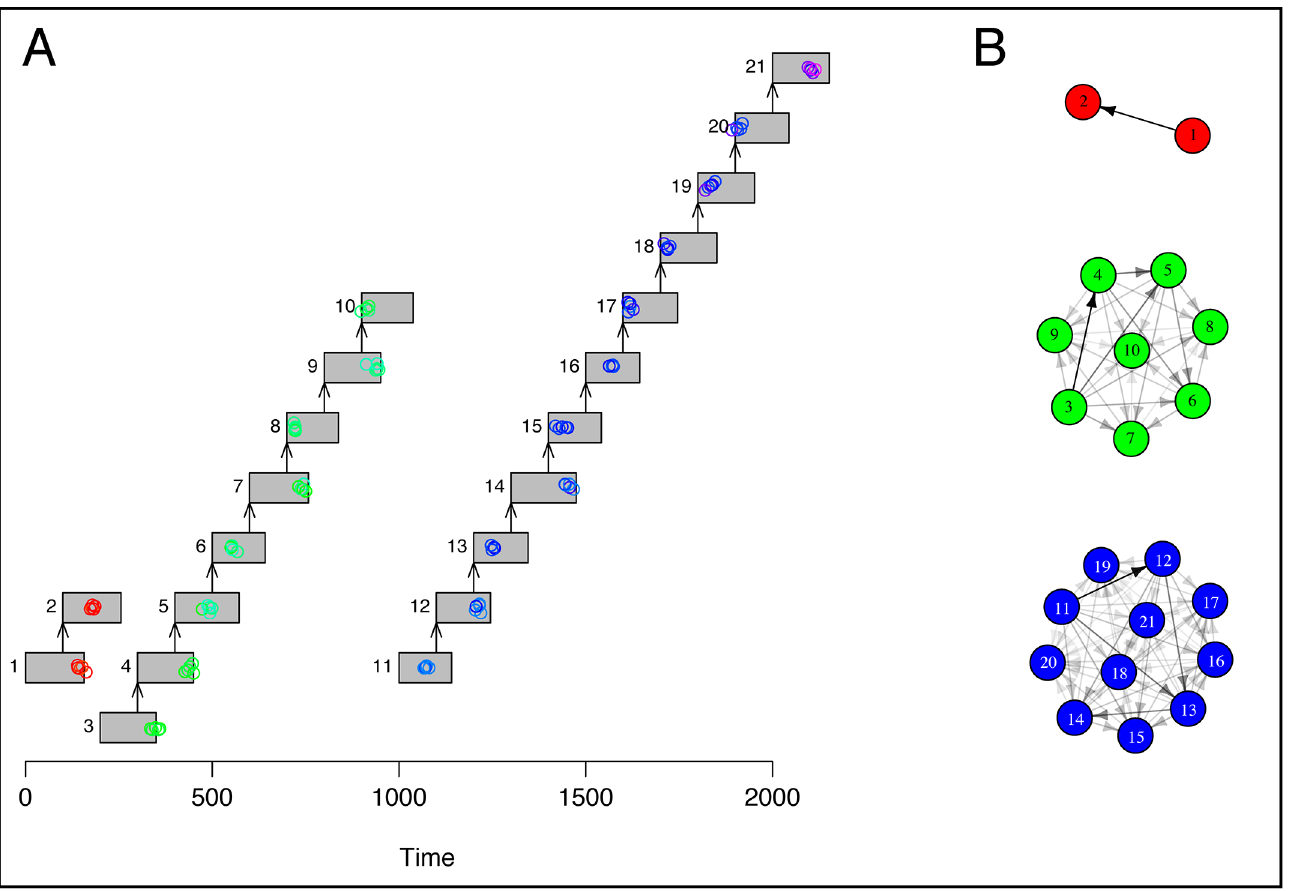
Fig 6. Evolutionary dynamics and estimated routes of infection on a disconnected transmission tree. We simulated evolutionary dynamics on top of a pre-specified transmission tree, in which three cases are imported to the community under observation. (A) Genomes are represented by colored circles, colored according to genetic distance from the first sampled genome in individual 1; red denotes an identical genotype, while colors closer to the blue end of the spectrum denote an increasing genetic distance from this reference genome. The expected genetic distance between imported cases was 12 SNPs. (B) Estimated routes of infection. We assumed that recovery times were not observed, such that any previously infected host could be the source of infection at the time of transmission. Routes with posterior probability < 0.05 are not shown. This network diagram was plotted using the igraph package